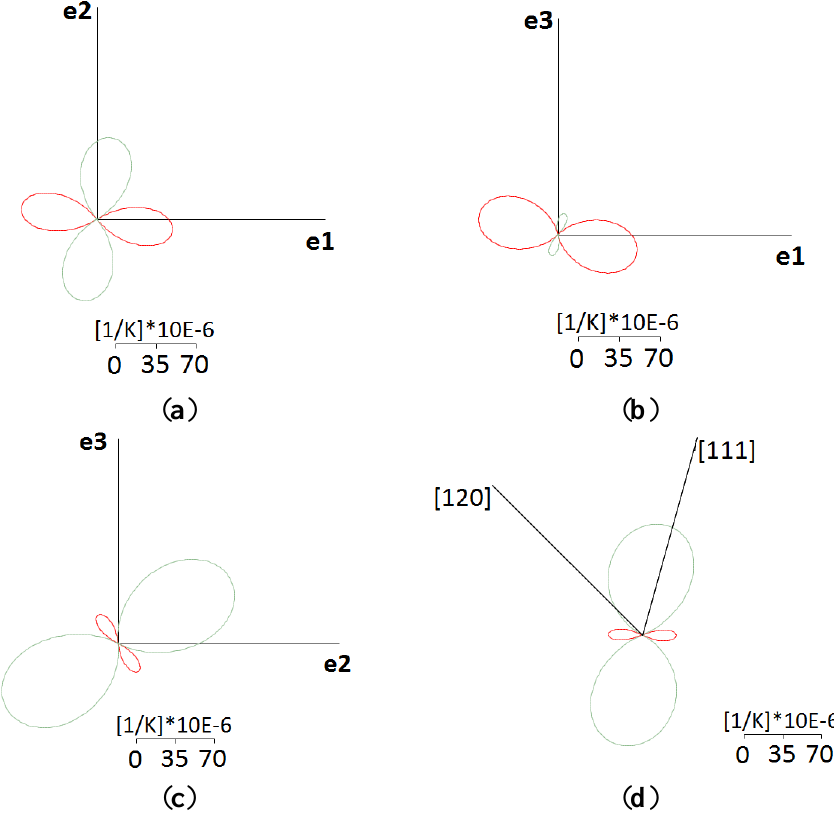
Figure 5. Three default ( a – c ) and specific ( d ) sections through the 3-D representation surface for α-CuMoO 4 at 70